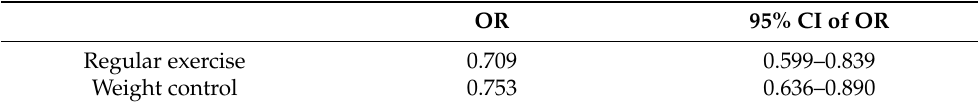
Table 5. Individual risk of osteoporosis for T-Score ≤ −